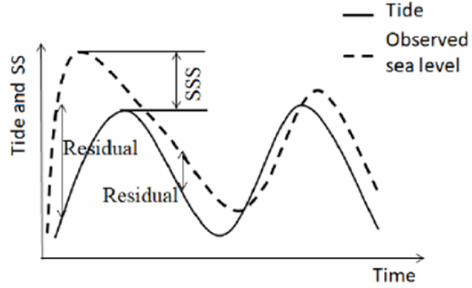
Figure 1. Definition and schematic representation of a skew storm